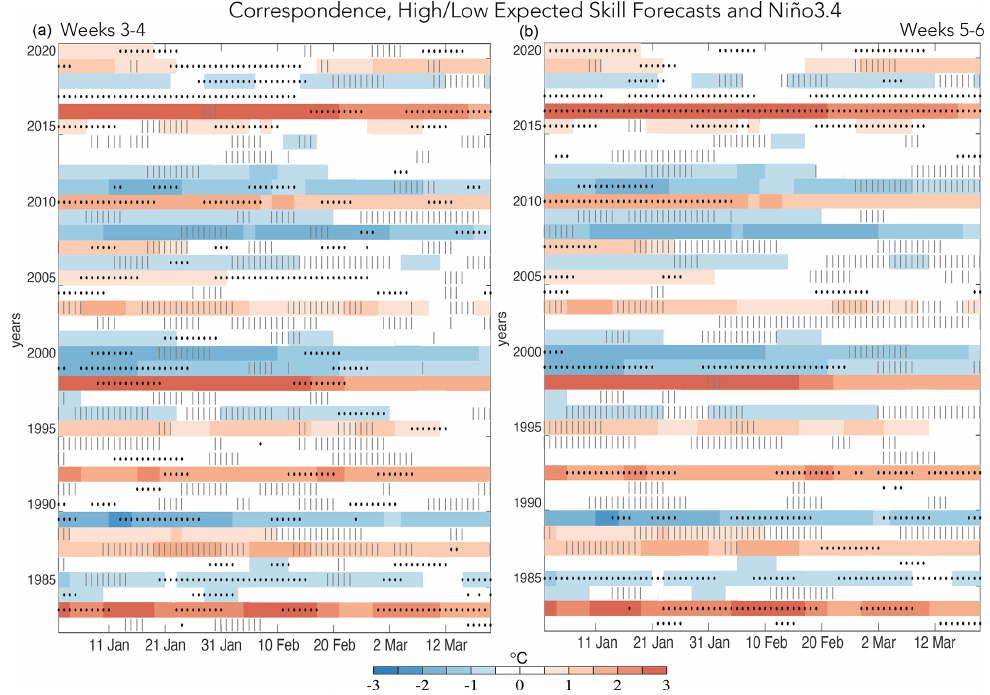
Figure 6. The color shading shows the Niño3.4 index and is the same in both panels. The black dots indicate the top 20% of expected- skill forecasts, and the gray vertical lines represent the bottom 20% of expected-skill forecasts, for weeks 3–4 forecasts (a) and weeks 5–6 forecasts (b) .